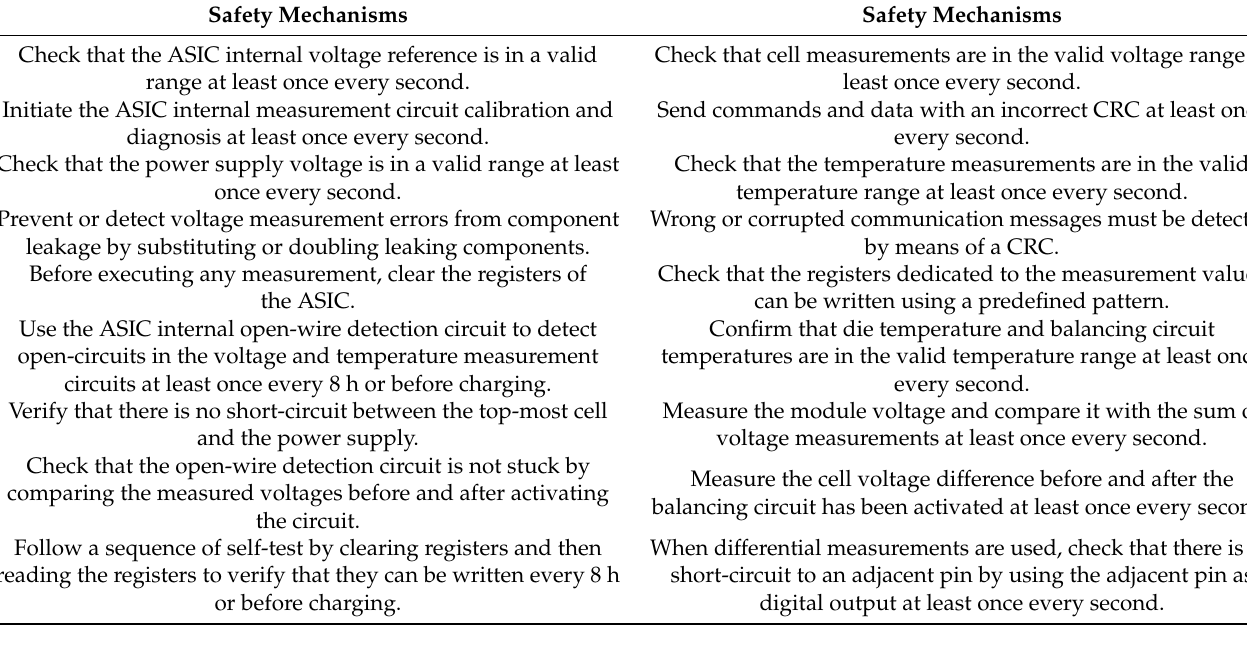
Table 7. Safety mechanisms of the enhanced BMS Slave.